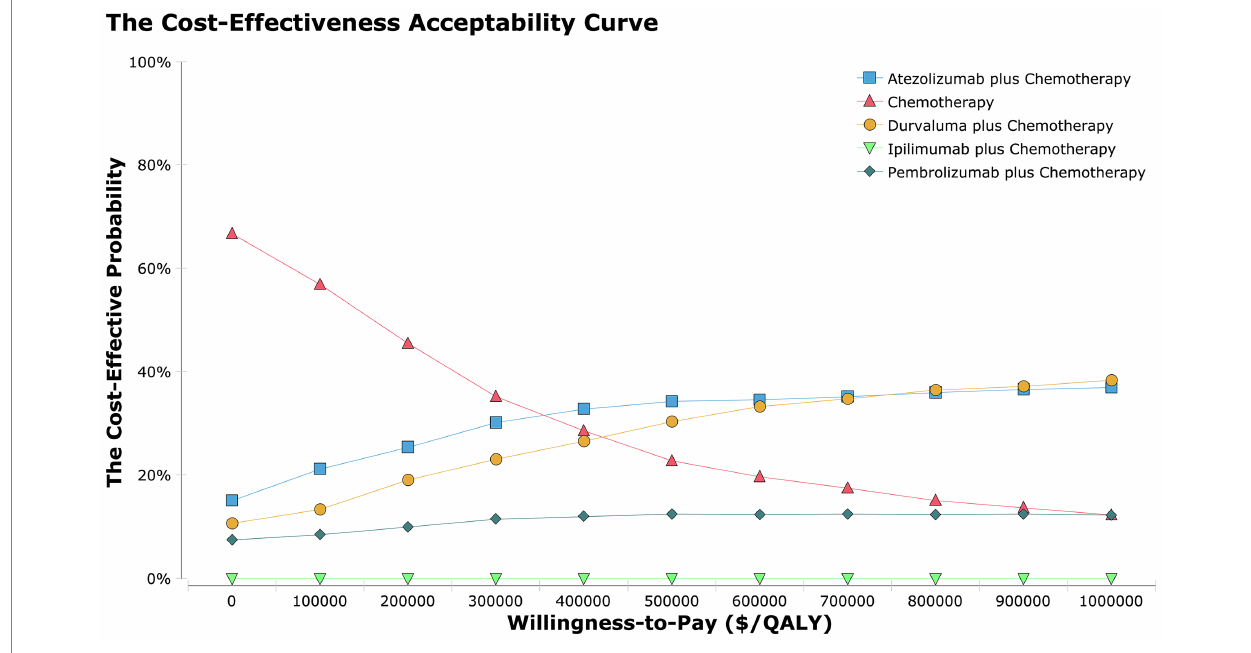
FIGURE 3 The cost-effectiveness acceptability curves for the atezolizumab plus chemotherapy, durvaluma plus chemotherapy, pembrolizumab plus chemotherapy, ipilimumab plus chemotherapy strategies compared to the chemotherapy strategy in the overall